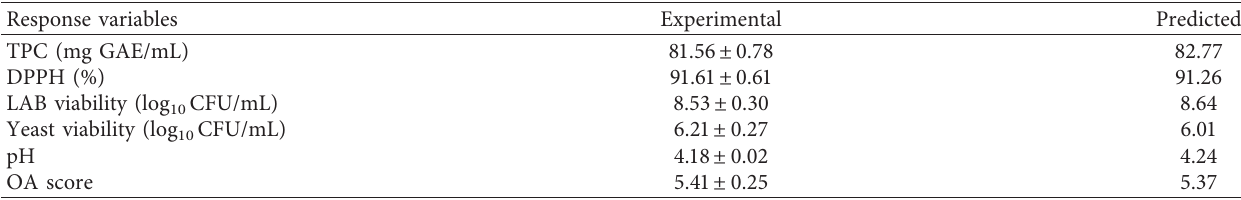
Figure 5: Response surface and contour plots representing the effect of WP and MJ on overall acceptability ( X w/v)). Table 6: Predicted and experimental values of responses under optimum conditions. Response variables